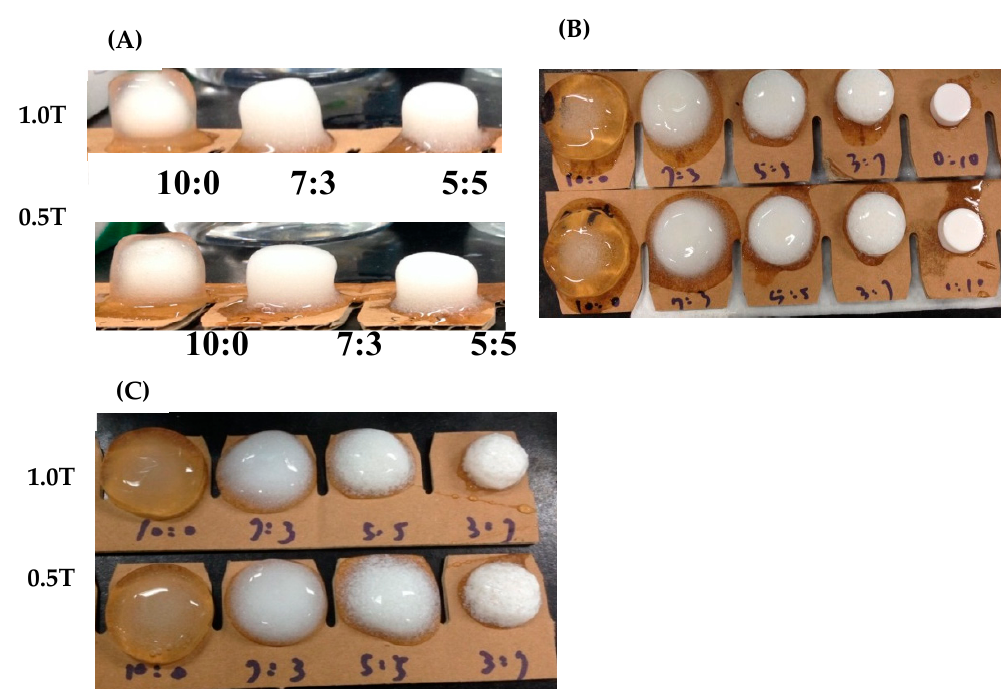
Figure 1. Photographs of different hydrogel tablets after swelling for 24 h in simulated gastric fluid (SGF). ( A ) HPMC 90SH 100K; ( B ) HEC 250HHX; ( C ) PEO7000K.